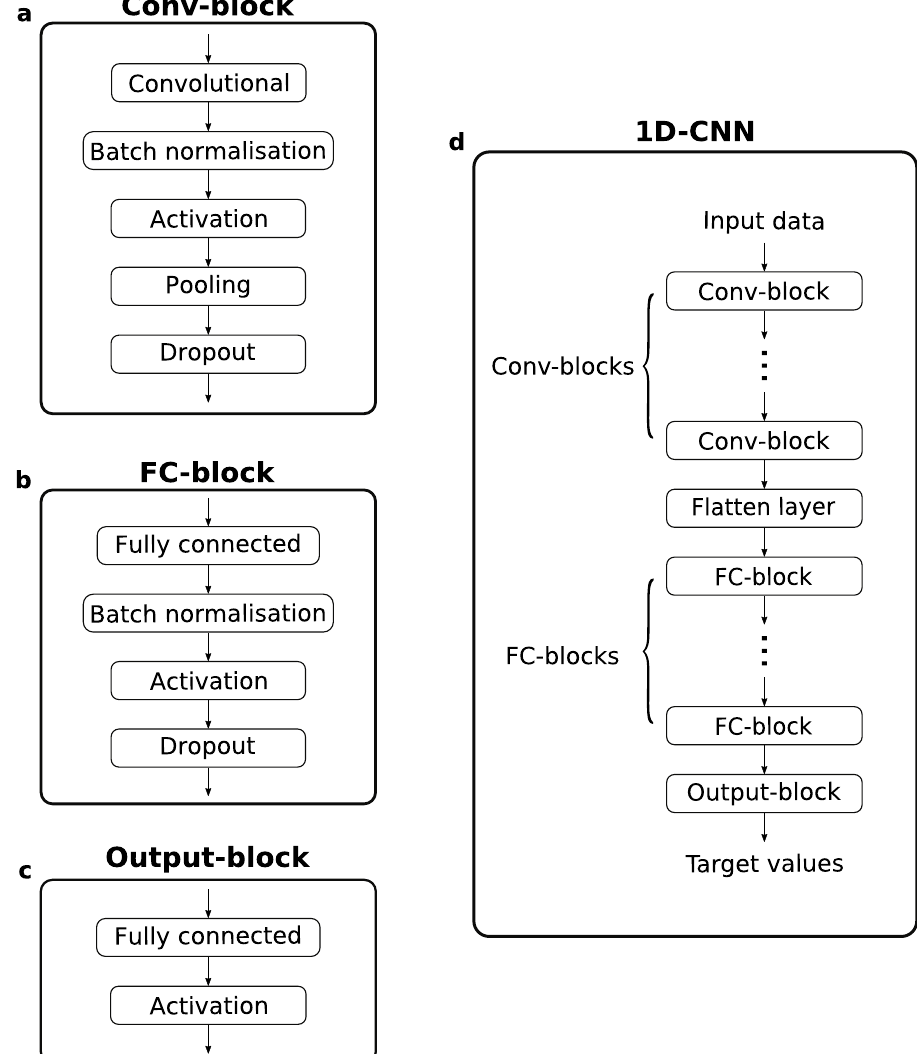
Figure 6. 1D-CNN building blocks. ( a ) Convolutional block. ( b ) Fully-connected block. ( c ) Output block. ( d ) Construction of a 1D-CNN using the